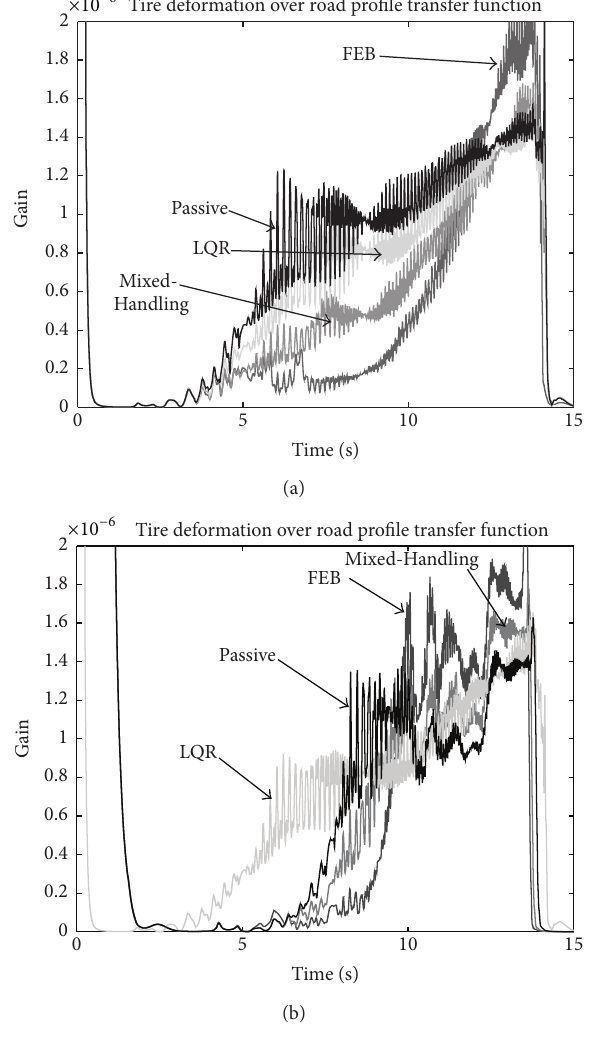
Figure 7: BSST: constant speed (top) and constant acceleration (bottom) tire deformation over the